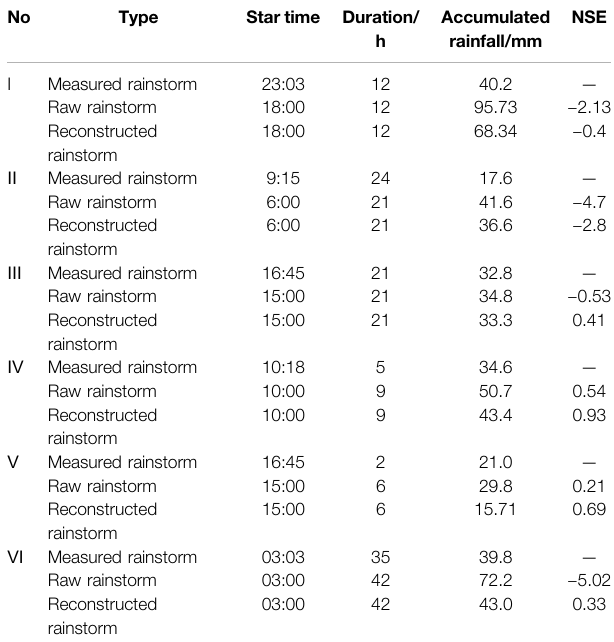
TABLE 4 | Characteristics of rainstorms with and without the reconstructed